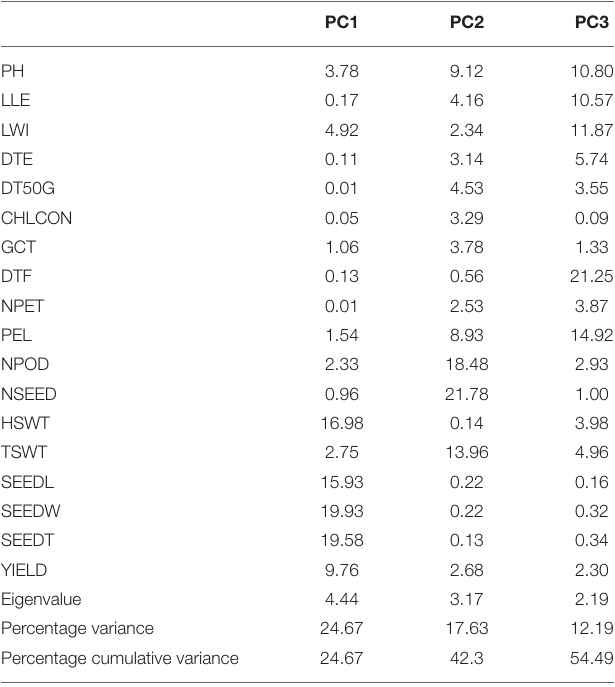
TABLE 6 | Trait contributions, eigenvalues, and cumulative percentage of the